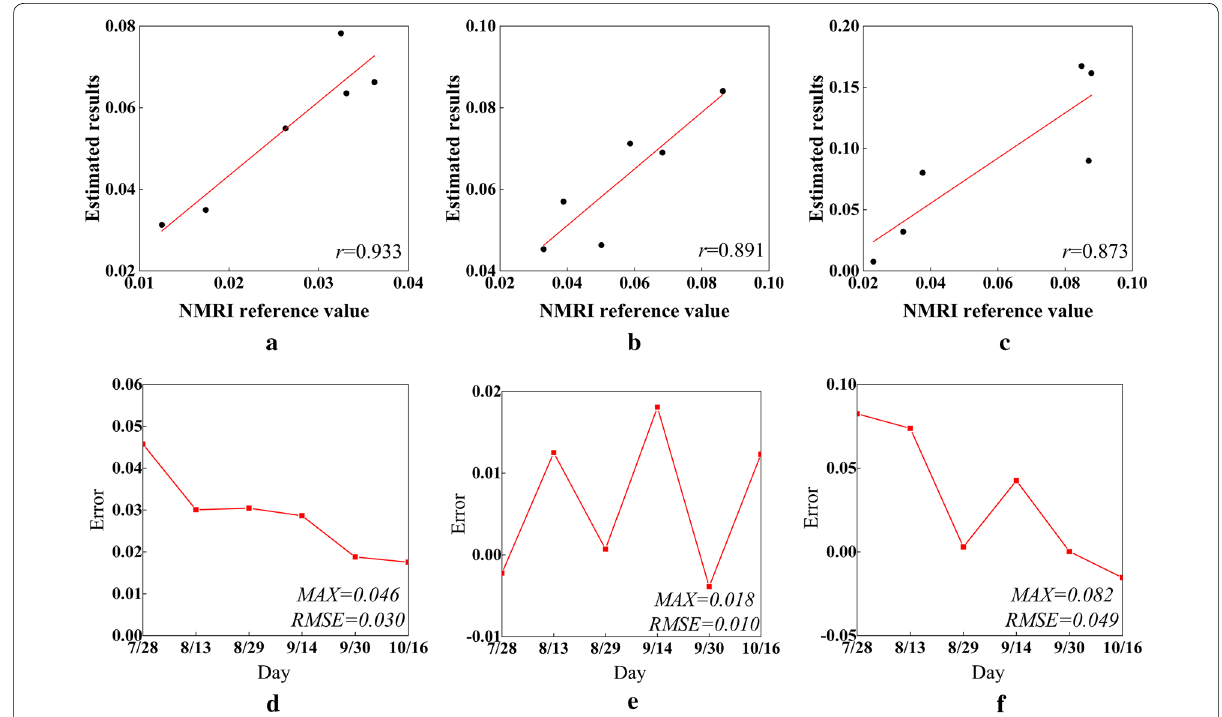
Fig. 12 Unmodeled station accuracy analysis: a P112 r ; b P354 r ; c P359 r ; d P112 RMSE, MAX; e P354 RMSE, MAX; f P359 RMSE,